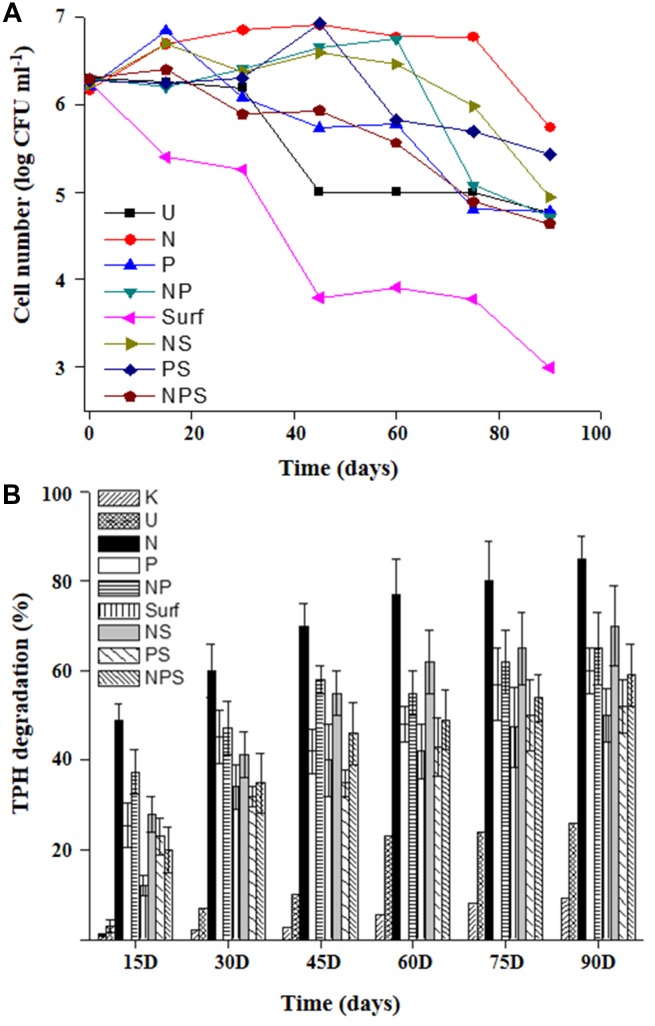
Hydrocarbon degradation profile and cell viability in microcosms. Cell viability (A) and TPH biodegradation (B) profiles of the sludge community undergoing different treatments during microcosm based biostimulation experiment. For legend details refer Table 1.